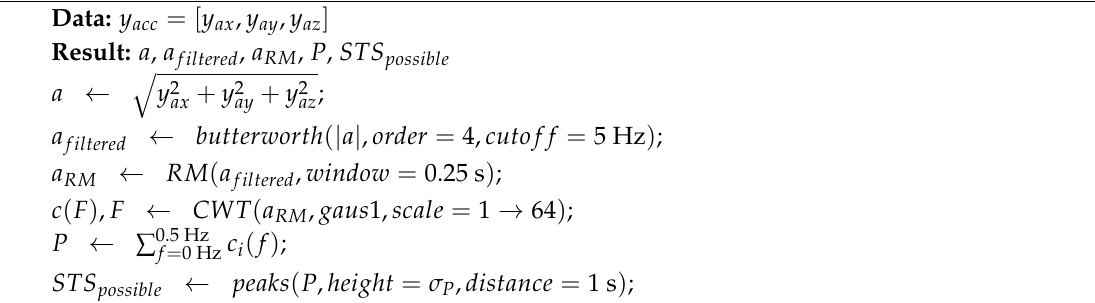
Algorithm 1: Raw acceleration filtering and transformations, and STS possible location identification. RM is rolling mean, CWT is continuous wavelet